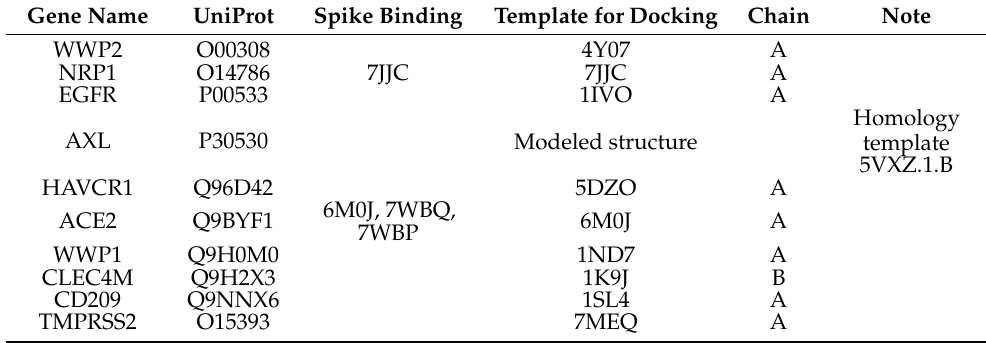
Table 1. Structures of SARS-CoV-2 S protein’s isolated interactions.